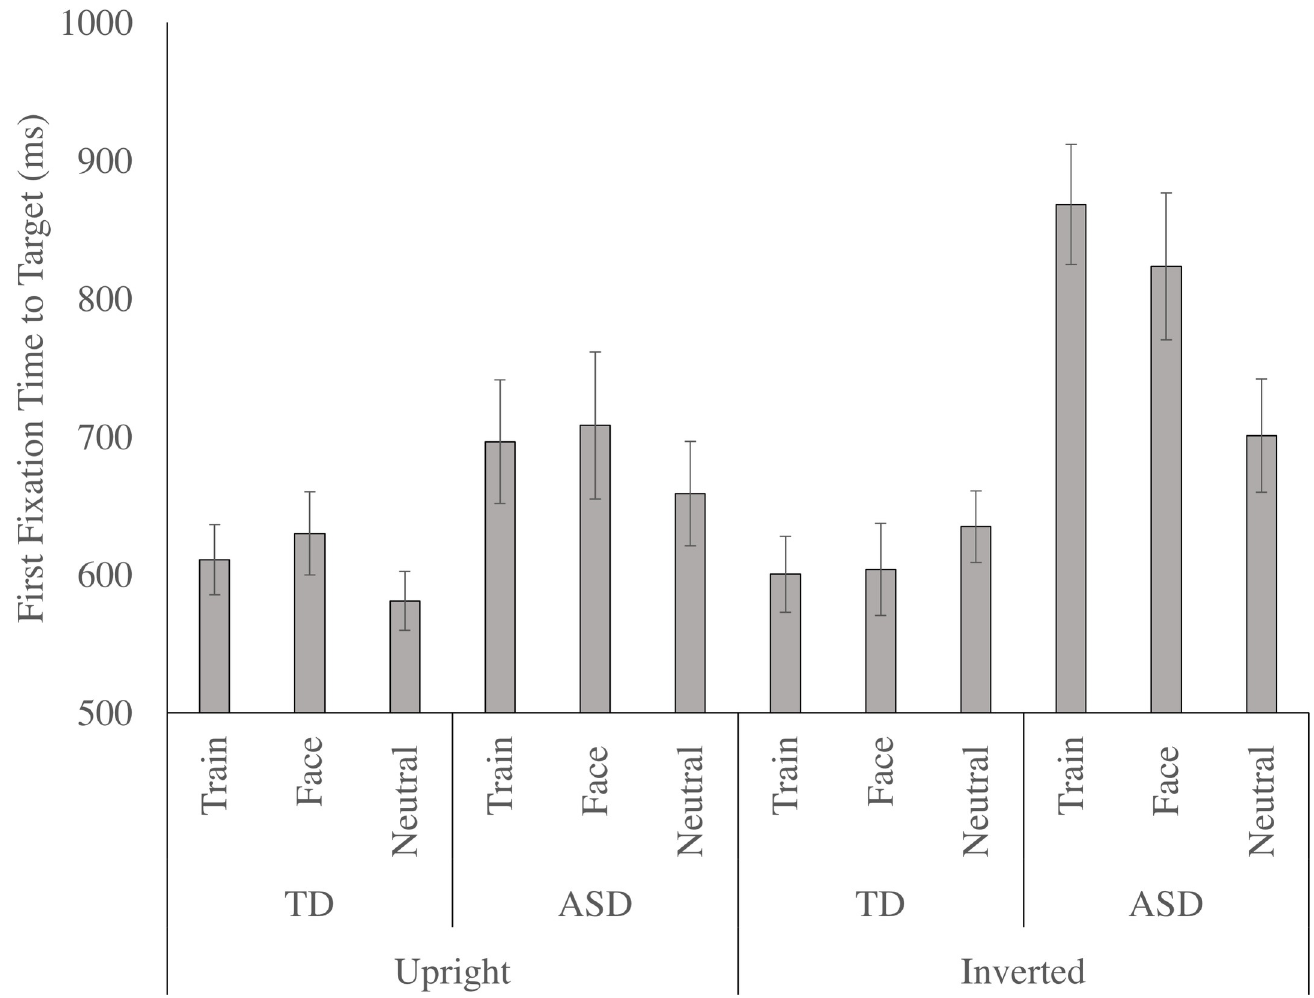
Fig 5. The time elapsed between the beginning of the trial and the first fixation to the target, or the first fixation time to target (mean and standard error), for autistic and non-autistic children in the upright and inverted stimulus conditions as a function of distractor (neutral, train, face).